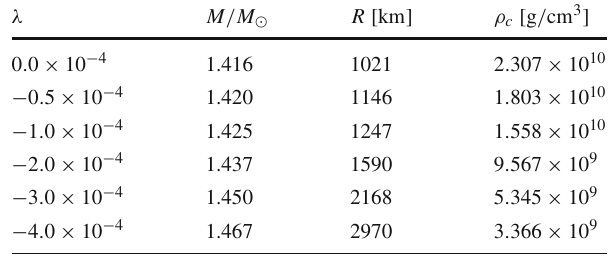
Table1 Themaximummassesofthewhitedwarfsfoundforeachvalue of λ with their respective total radii and central energy densities